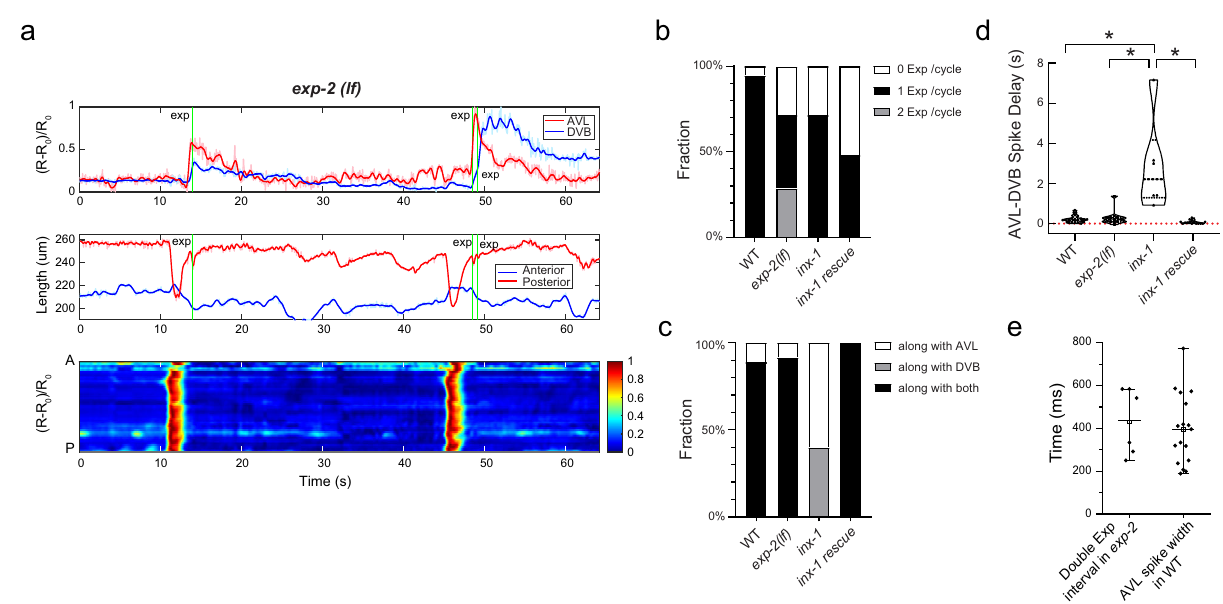
Fig. 7 The AVL negative spike inhibits excessive expulsion per defecation cycle. a Top: Representative (normalized) calcium activities of AVL (red) and DVB soma (blue) in exp-2 ( lf ) mutants. Middle: Corresponding changes of the length of the anterior (blue) and posterior (red) half of the worm body. Bottom: Corresponding normalized intestinal calcium activities along the worm body axis (A: anterior, P: posterior). Green vertical lines: Timing of expulsion. b Fraction of DMP cycles associated with different numbers of expulsion occurrence (WT: n = 19 from 12 animals; exp-2 ( lf ): n = 21 from 6 animals; inx-1 : n = 14 from 3 animals; inx-1 (rescue): n = 25 from 5 animals). c Fraction of expulsions per cycle associated with AVL or DVB fi ring or both (WT: n = 18 from 12 animals; exp-2 ( lf ): n = 12 from 6 animals; inx-1 : n = 10 from 3 animals; inx-1 (rescue): n = 12 from 5 animals). d Time delay between AVL and DVB spikes in wild-type, exp-2 ( lf ), inx-1 , and inx-1 rescued animals (WT: n = 19 from 12 animals; exp-2 ( lf ): n = 12 from 6 animals; inx-1 : n = 6 from 3 animals; inx-1 (rescue): n = 12 from 5 animals). Data were presented in a violin plot. Asterisks indicate signi fi cant differences: * P < 0.05 in unpaired Student ’ s t -test with Welch ’ s correction. The statistical test was two-sided. WT vs inx-1 : P = 0.0382; inx-1 vs inx-1 (rescue): P = 0.0318; exp ( lf ) vs inx-1 : P = 0.0413. e Time delay between two consecutive expulsions within the same cycle in exp-2 ( lf ) mutants ( n = 6) and the spike width of AVL action potentials in wild-type animals ( n = 17). Data were presented as mean values ± SEM. The center is the mean value and the error bar is SEM. Source data are provided as a Source Data fi